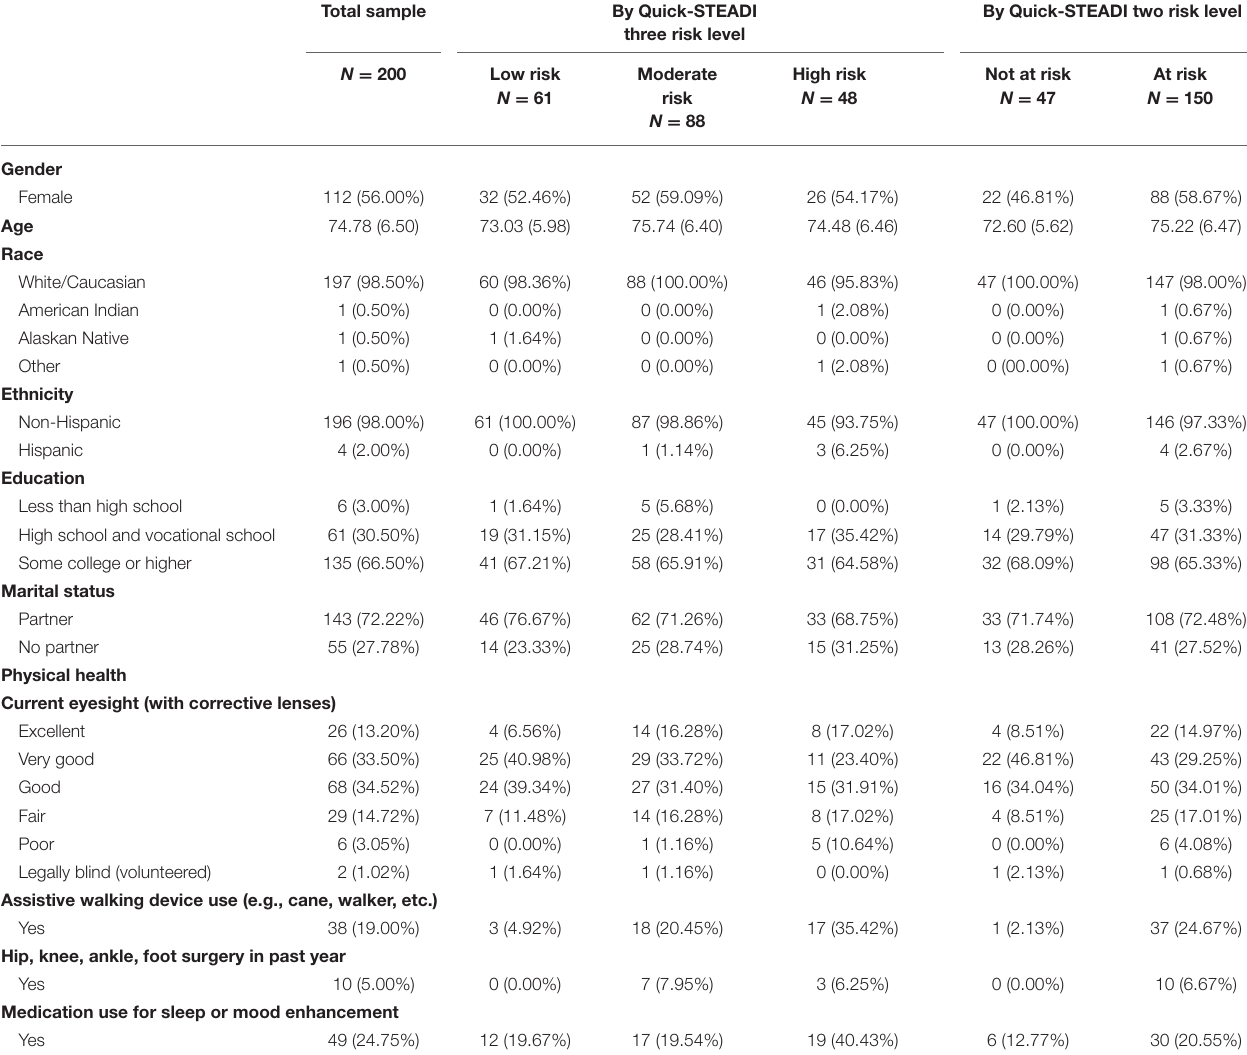
TABLE 1 | Characteristics of Quick-STEADI Participants. Total sample By Quick-STEADI three risk